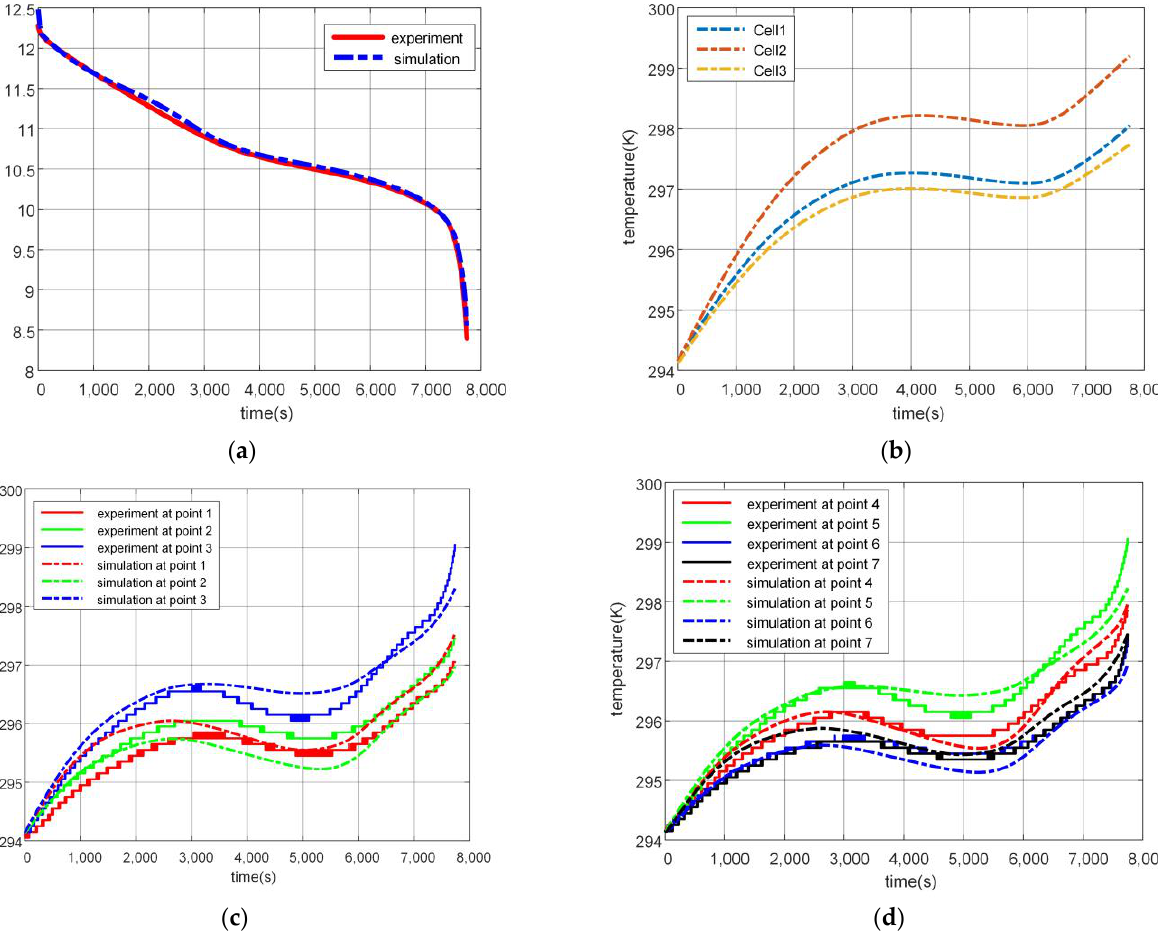
Figure 9. Simulation results of battery pack at constant current 20 A at 20 °C . ( a ) Comparison of total terminal voltage. ( b ) Comparison of internal temperature. ( c ) Comparison of temperature at points 1–3. ( d ) Comparison of temperature at points 4–7. Table 5. Mean absolute errors of temperature.